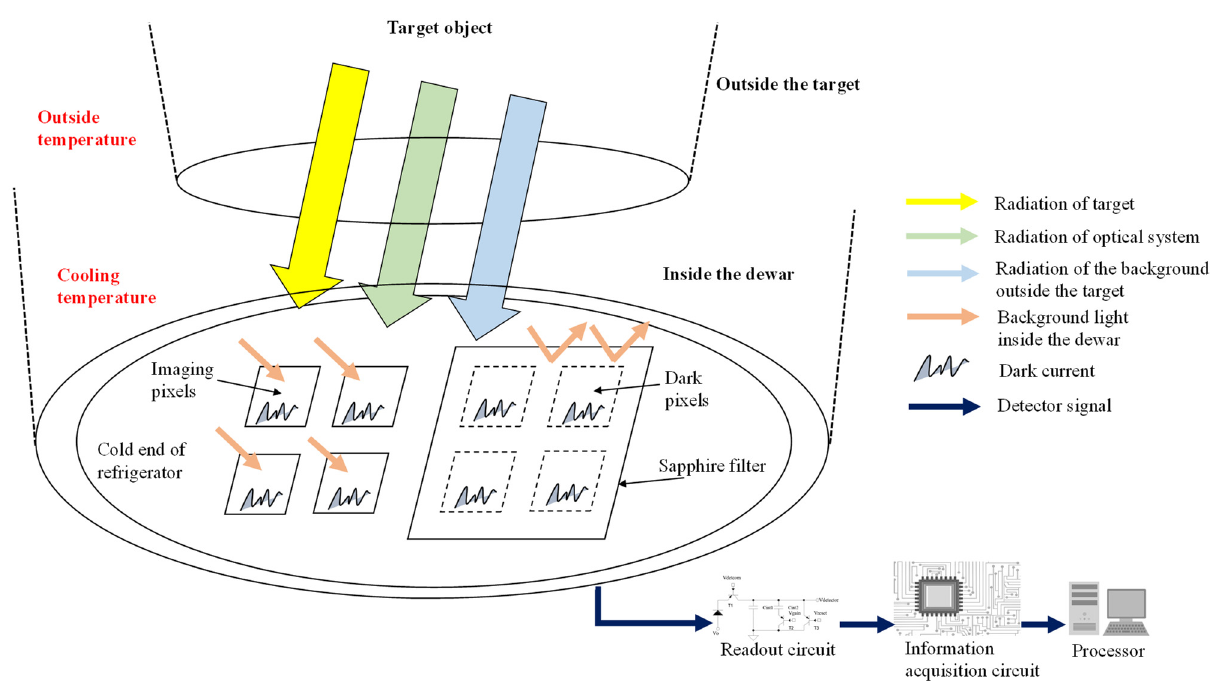
Figure 5. Source composition of the radiation received by two pixel types.